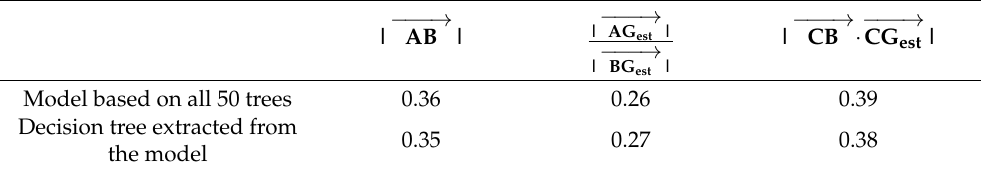
Table 3. Importance of the features in the model created by the RF analysis.